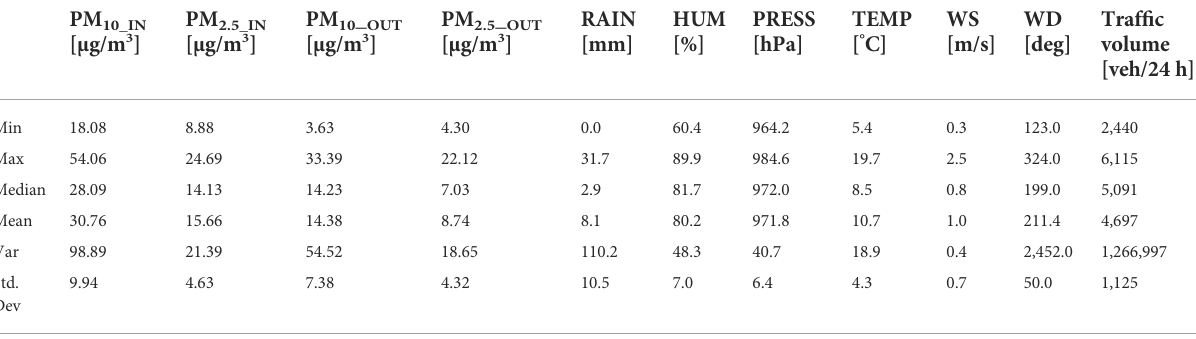
TABLE 1 Statistical characteristics of PM, meteorological conditions, and traf fi c volume (RAIN — precipitation, HUM — humidity, PRESS — pressure, TEMP — temperature, WS — wind speed, and WD — wind